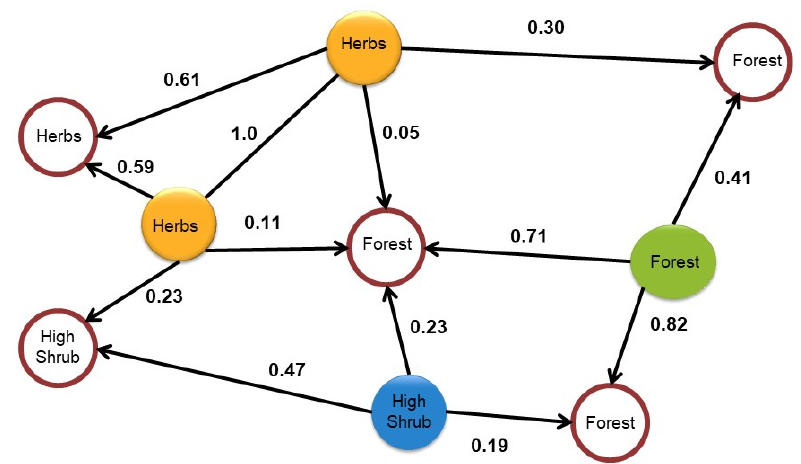
Figure 4. Illustration of label propagation procedure. Coloured circles represent four different labelled samples, and white circles represent unlabelled samples. Values indicate the probability of edges. Propagation direction is shown by the direction of the arrows, i.e., the arrow is always from a labelled sample to an unlabelled sample.